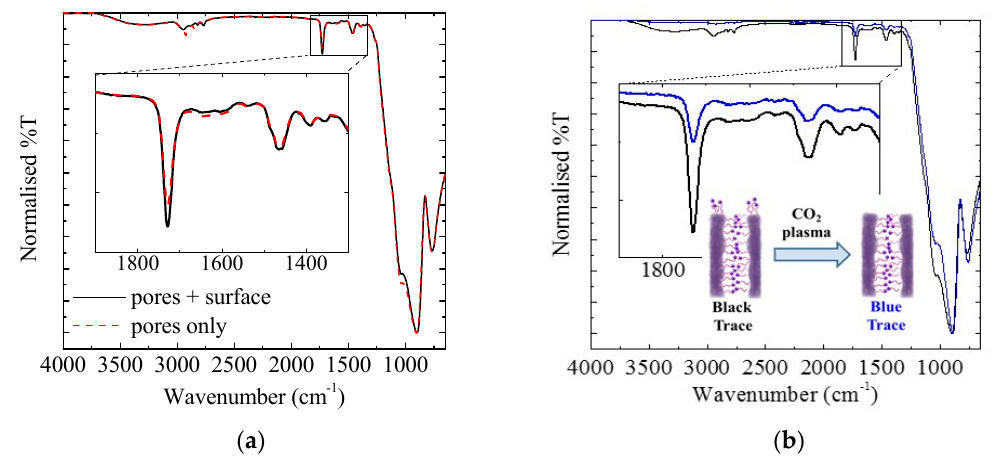
Figure 3. The presence of polymerisable groups and subsequent formation of a polymer on the exterior surface can hinder the formation of polymer within the mesopores: ( a ) IR spectra of 5SBDCSi after performing a SIP for 60 min where the SIP is confined exclusively to the pores ( - - - - ), and the pores and exterior surface ( ―― ); ( b ) IR spectra before ( ―― ) and after ( ―― ) performing an additional CO 2 plasma treatment to remove the polymer formed on the exterior surface after polymerisation. Reaction conditions: DMAEMA:DMF = 1:8 ( v / v ), 1 h, 320–400 nm.